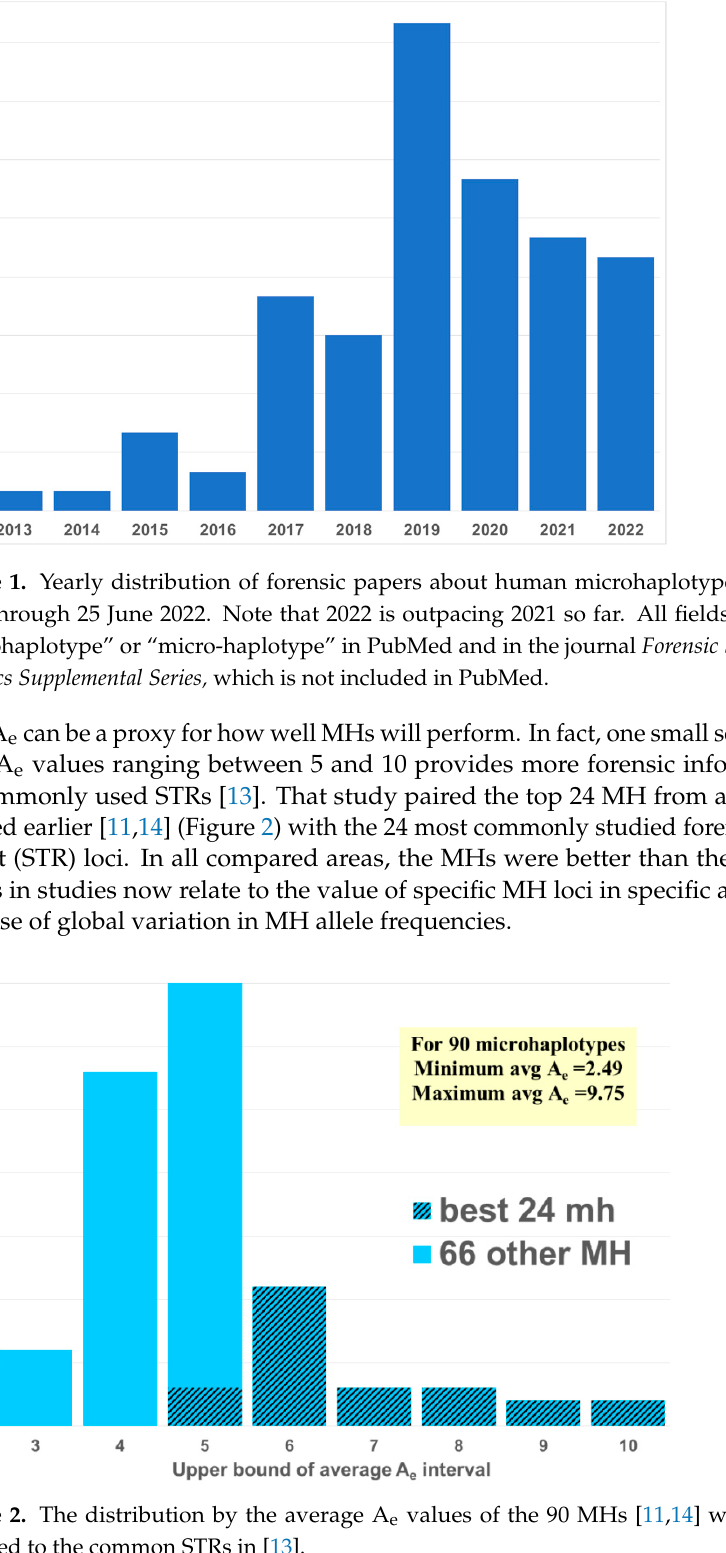
Figure 2. The distribution by the average A e values of the 90 MHs [11,14] with the 24 MH [13] matched to the common STRs in [13].